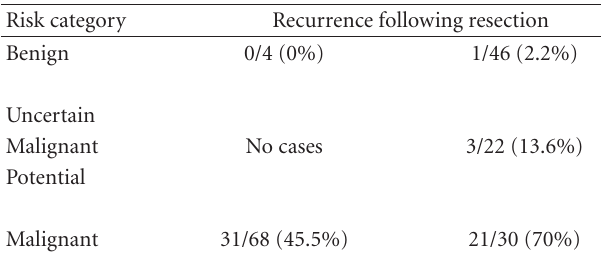
Table 4: Comparison of original and revised Folpe criteria in risk